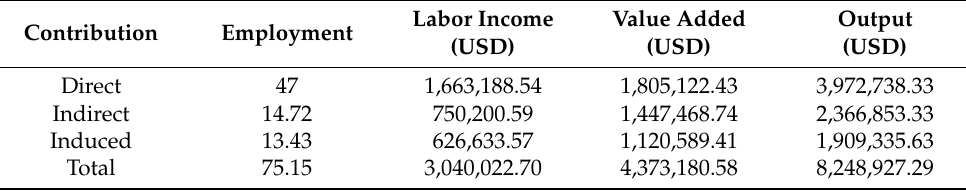
Table A4. Contribution of Partner Spending to Duval, Flagler, and St. Johns Counties (Annual).